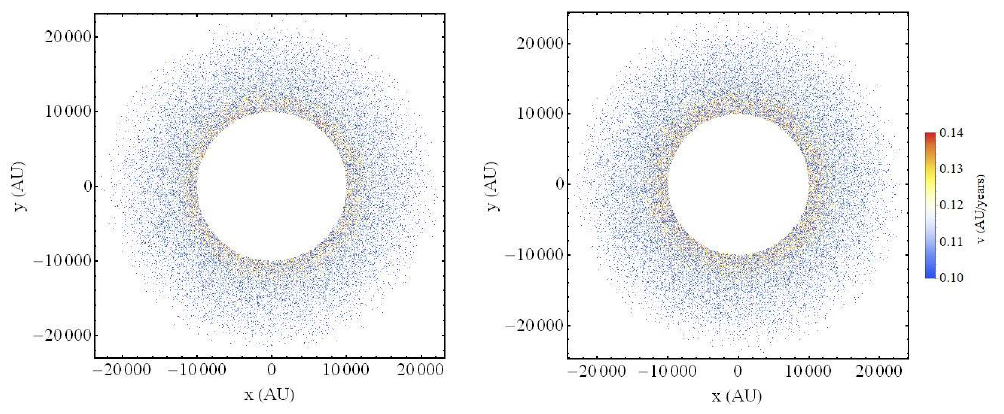
Figure 6. Left panel: The 2D scatter plot of the positions of the collection of points used in the Monte Carlo analysis (excluding those that evolve to parabolic trajectories), colored by the value of their individual velocity before the gravitational transition. Right panel: The 2D scatter plot of the positions of the points used in the Monte Carlo process, maintaining elliptic orbits, colored by the value of their individual velocity after the gravitational transition. The increased initial velocity is due to the increased gravitational strength, which requires higher velocity for an initial circular unperturbed